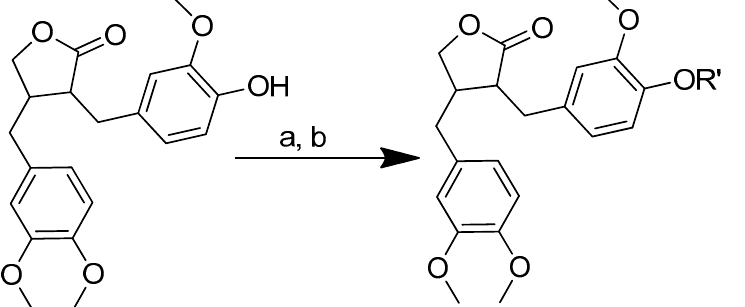
Scheme 16. Synthesis of amino acid–arctigenin conjugates. ( a ) C 2 H 3 N, EDCI, DMAP; ( b ) CH 3 COO CH 2 CH 3 , HCl. R in order: ( 3 ) L-methionine; ( 4 ) L-phenylalanine; ( 5 )